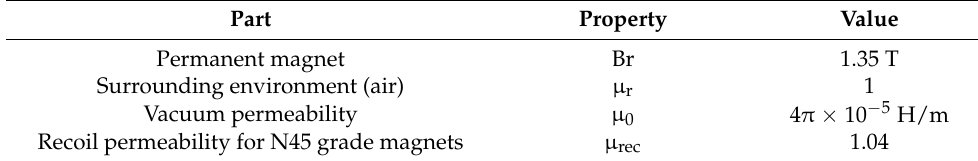
Table 3. Properties of the materials used in the COMSOL ® model. Part Property Value Permanent